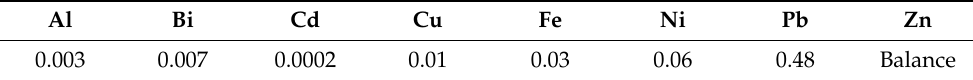
Table 7. Elemental composition (wt.%) of the zinc bath for the galvanizing process. Al